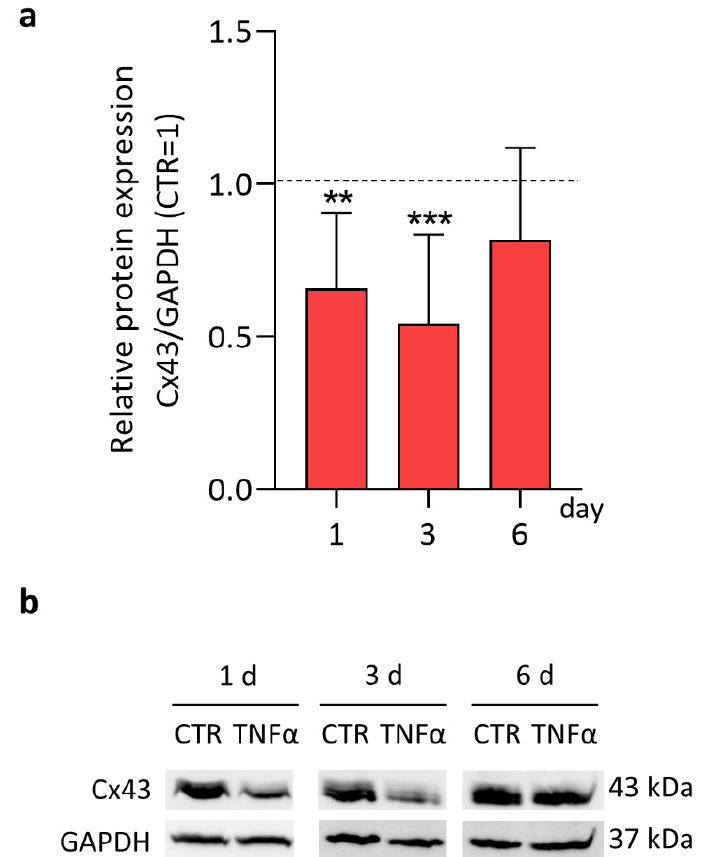
Figure 1. Expression of Cx43 in TNF α -stimulated CH at day 1, 3 and 6 analyzed by Western blot. ( a ) Specific bands were quantified through Image Lab Software v 6.1 (Bio-Rad, Milan, Italy), and data (day 1, n = 7; day 3–6, n = 11) were normalized on GAPDH and expressed as relative values (CTR = 1). Statistical analysis was performed by paired t test. Significance vs. appropriate CTR for each time point are shown as ** p < 0.01 and *** p < 0.001. ( b ) Representative immunoblots are shown. CTR: control (untreated CH).